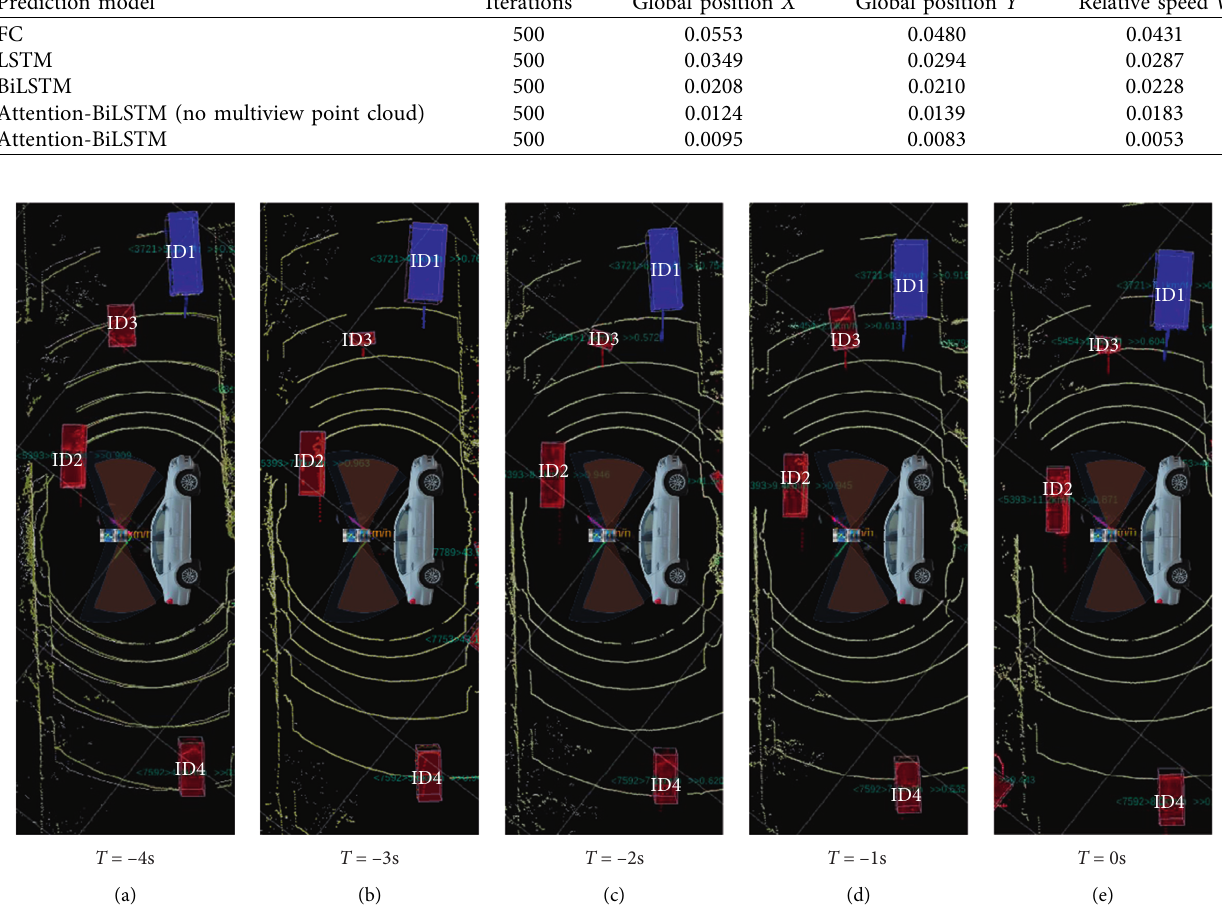
Figure 10: A historical continuous scene of interaction between an intelligent vehicle and four surrounding target vehicles. (a) T � −